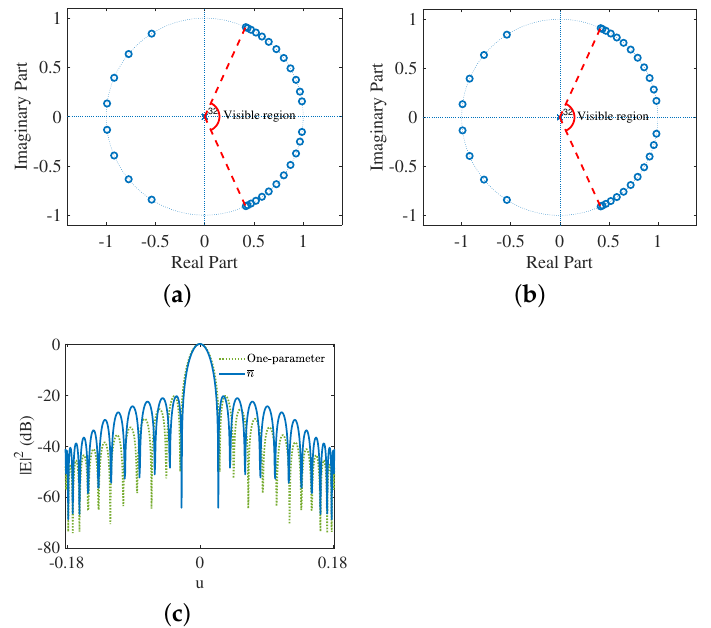
Figure 8. The simulated 33-element Taylor-like super-directive patterns with reduced maximum weighting ratio. ( a ) Zeros distribution of n Taylor-like super-directive pattern. ( b ) Zeros distribution of one-parameter Taylor-like super-directive pattern. ( c ) Patterns of n (blue line) and one-parameter (green dotted line) Taylor-like super-directive